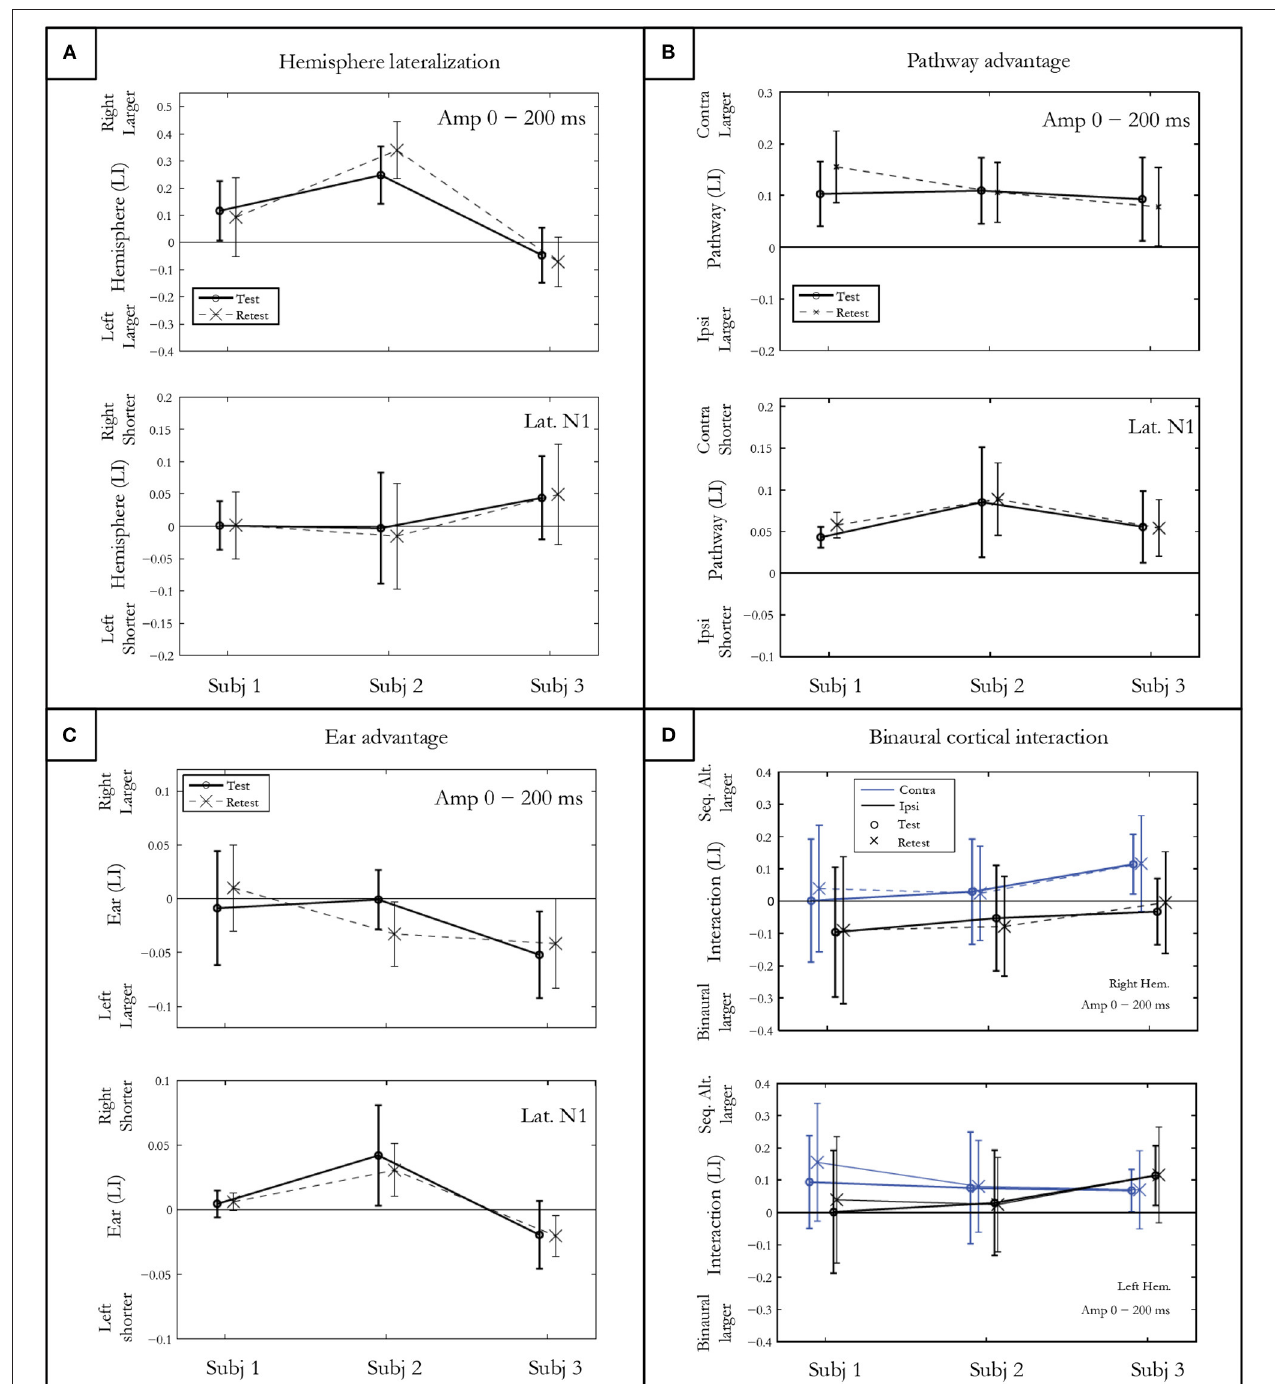
FIGURE 4 | Indices of hemispheric lateralization (A) , pathway advantage (B) , and ear advantage (C) for mGFP amplitudes in a 200ms post onset window, and for N100m latency. Both test and retest conditions are shown. The binaural cortical interaction (D) is represented for the mean mGFP amplitude in the right and left hemisphere for the contra- and ipsi-lateral pathways. Error bars denote standard deviations between conditions for each participant.